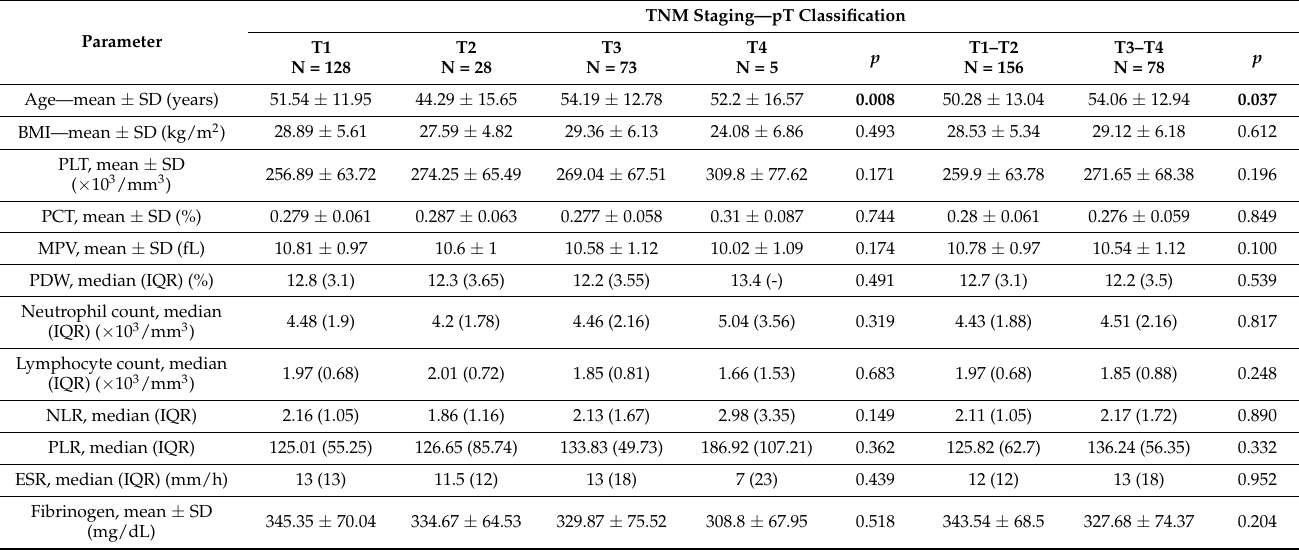
Table 6. Univariate comparative analysis of the inflammatory markers and platelet indices according to pathological pT classification.